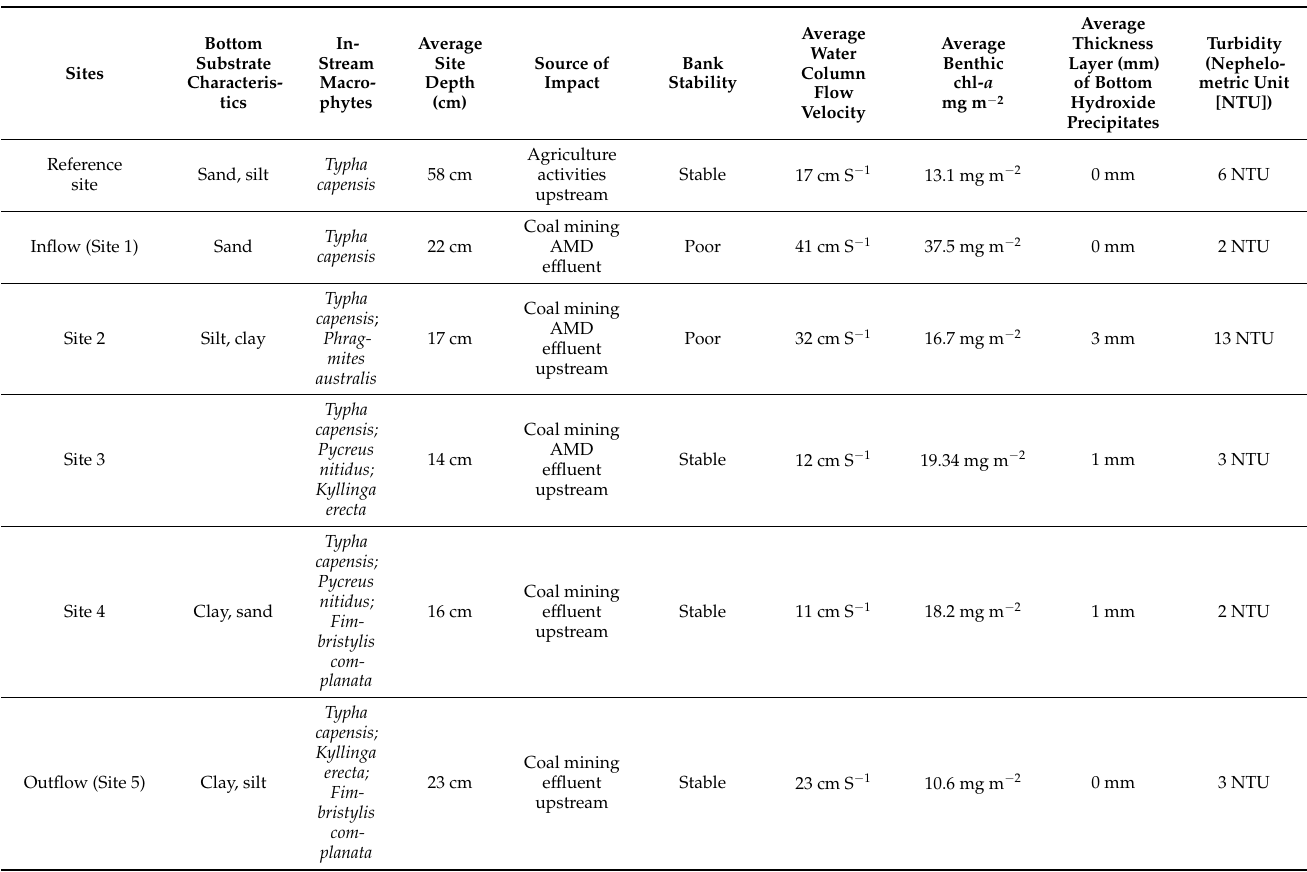
Table 1. Survey sites (six) description and biotic and abiotic characteristics over the sampling period of 2015–2018 ( n =